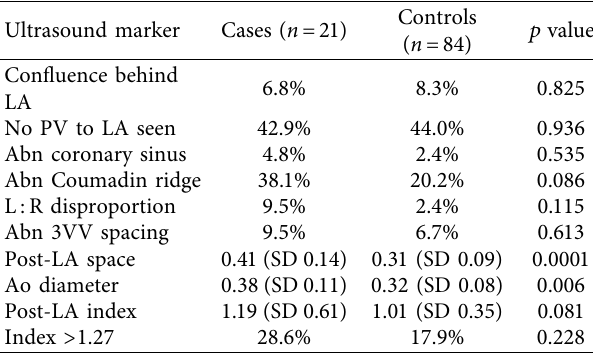
Table 1: Diferences in mid-trimester ultrasound characteristics between cases and controls, expressed as frequencies (in %) or means (with standard